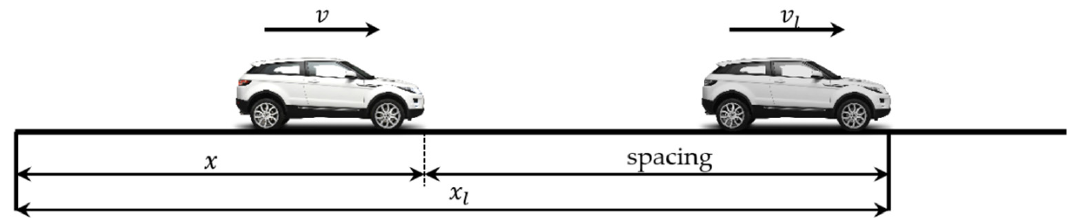
Figure 1. The kinematic relationship.